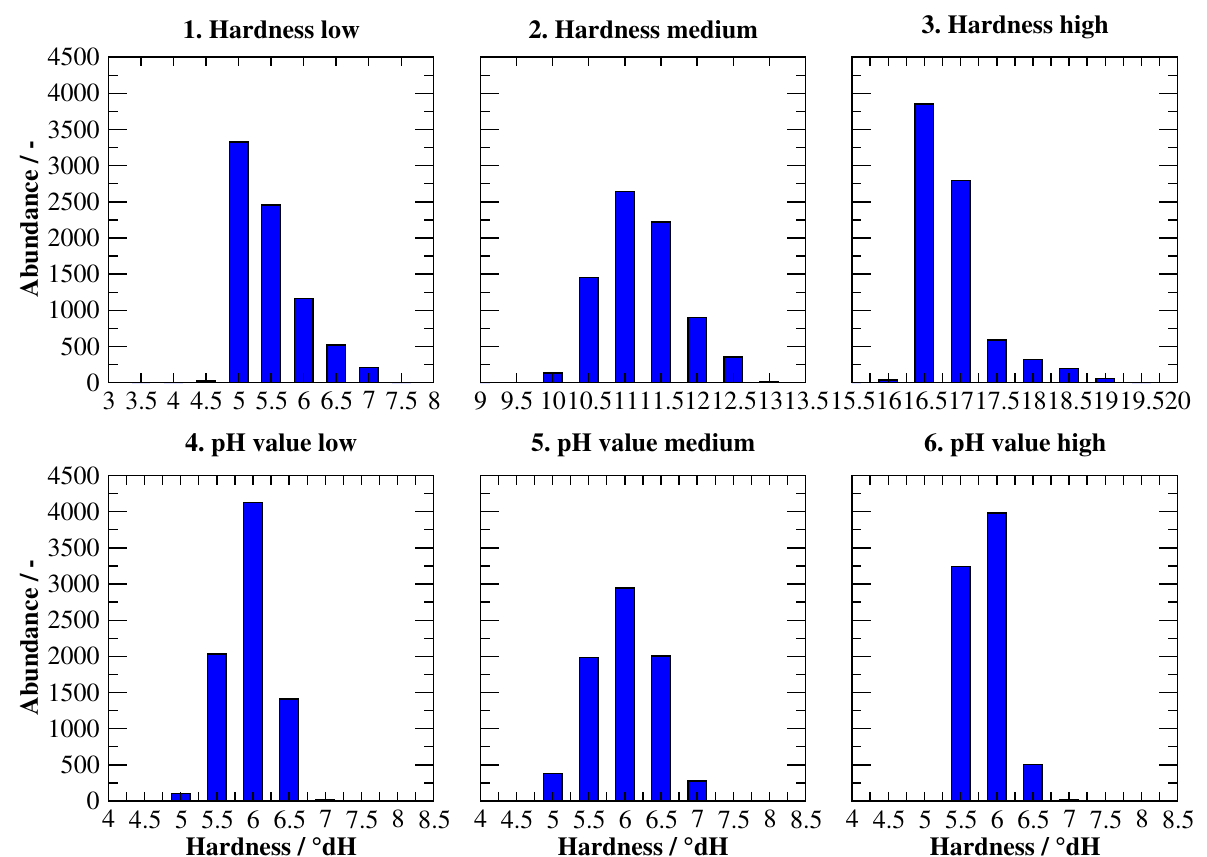
Figure 8. Frequency distribution of the measured degrees of hardness in the accelerated wear